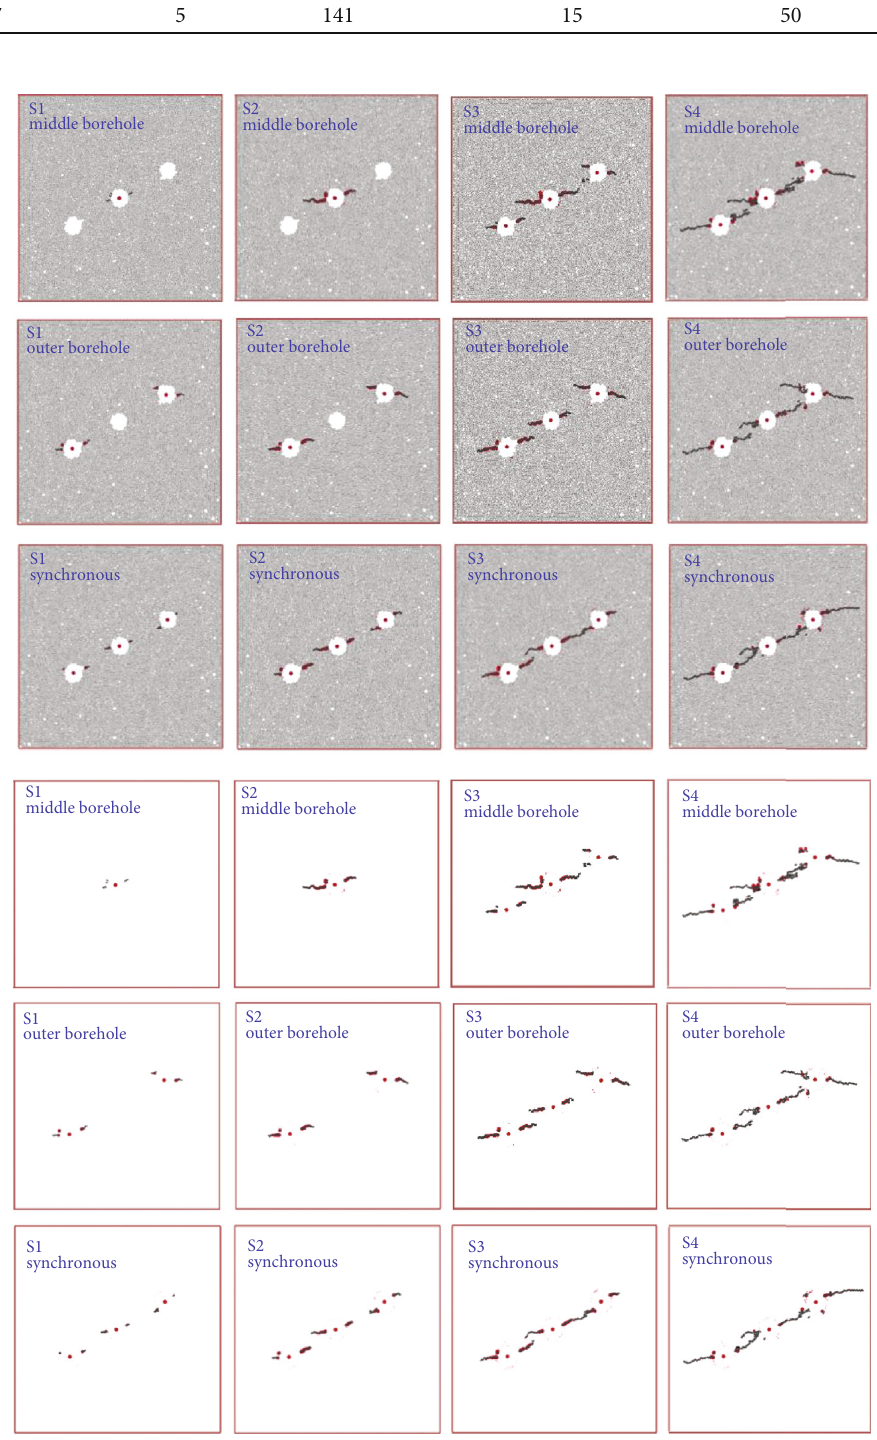
Figure 16: Initiation and propagation process of directional hydraulic fractures at borehole pumping